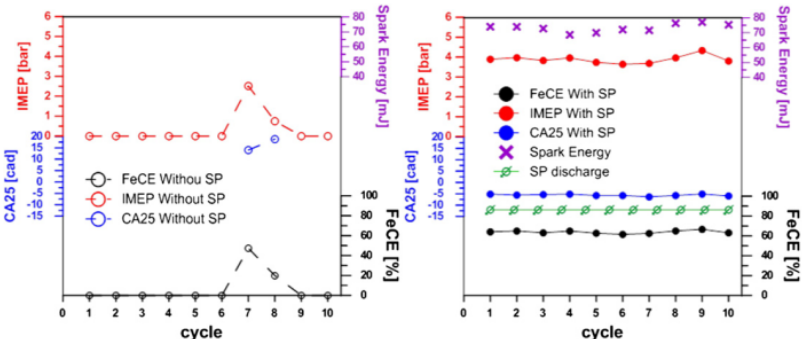
Fig. 10 Influence of spark assistance on combustion [80].